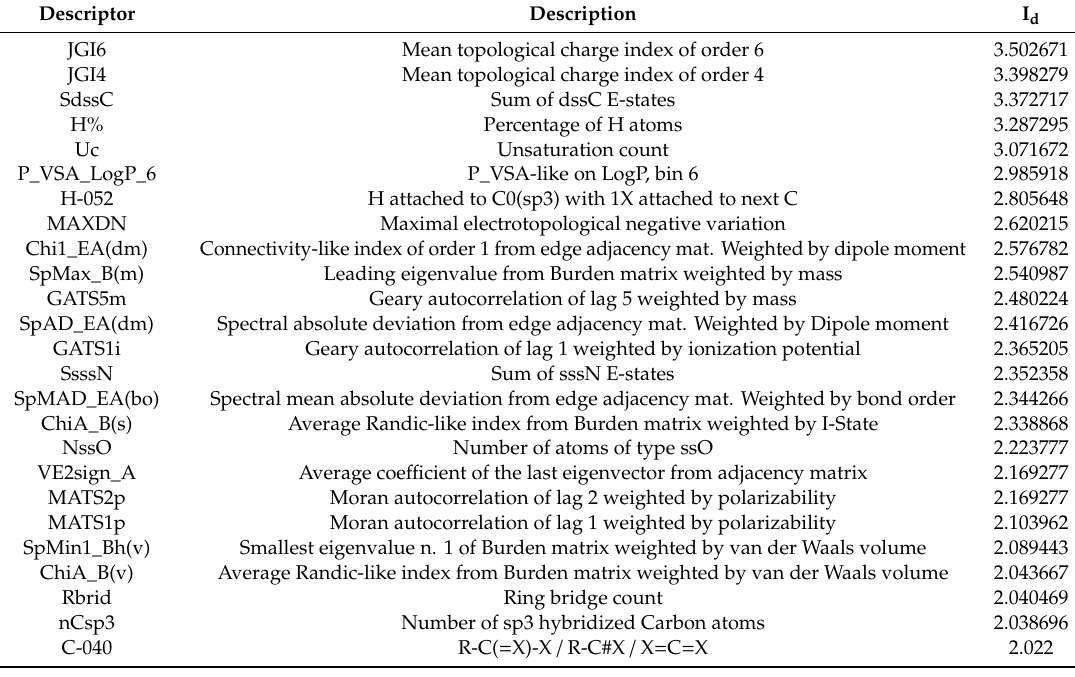
Table 6. Most important descriptors for models using the second modeling